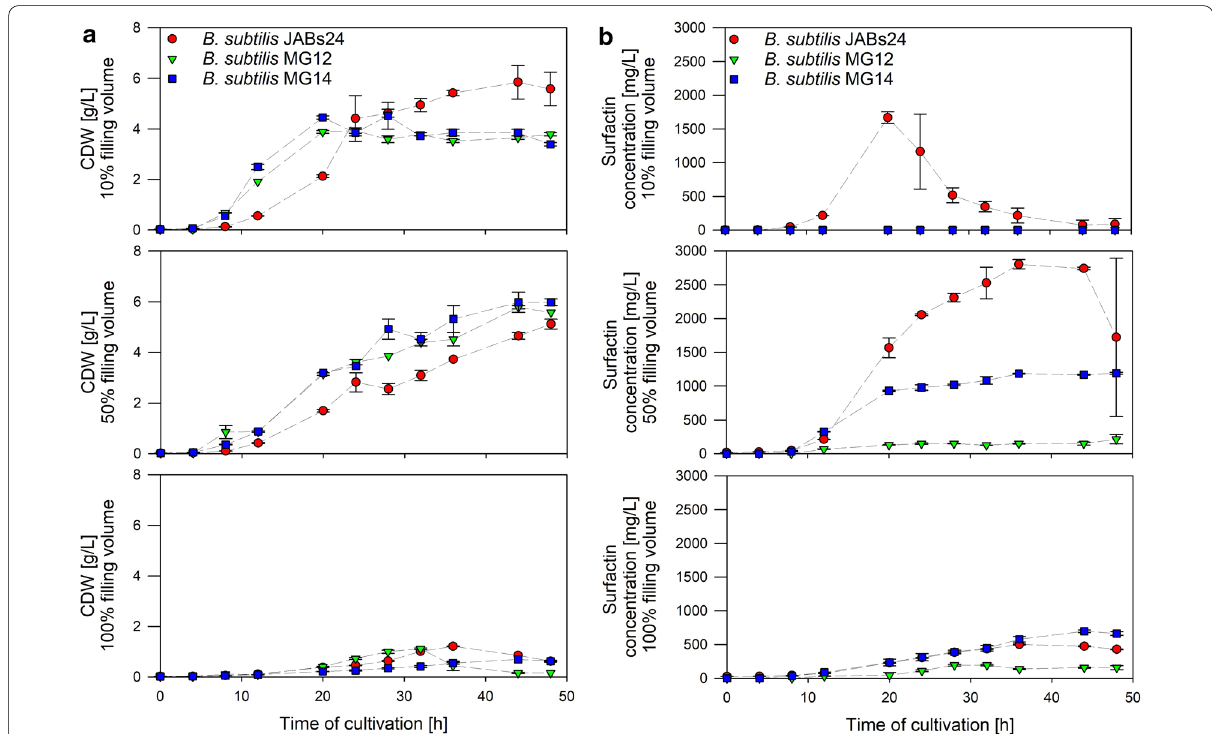
Fig. 3 Time course of cell dry weight (CDW) [g/L] ( a ) and surfactin concentration [mg/L] ( b ) of strains B. subtilis JABs24 (reference), MG12 (P narG - lacZ; amyE ::[P narG - lacZ, spcR ]) and MG14 (P srfA ::P nasD ; amyE ::[P nasD - lacZ, spcR ]) cultivated in a mineral salt medium with 40 g/L glucose, 0.1 mol/L NH 4 + and 0.1 mol/L